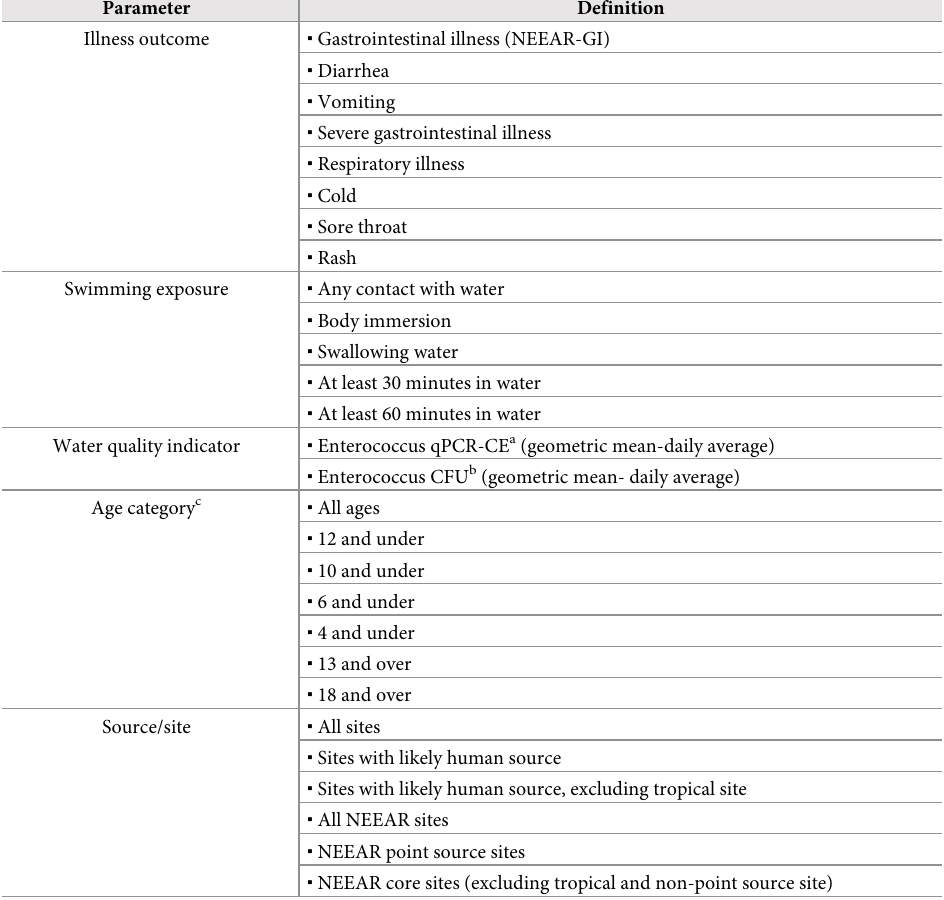
Table 1. Alternate categorizations for key